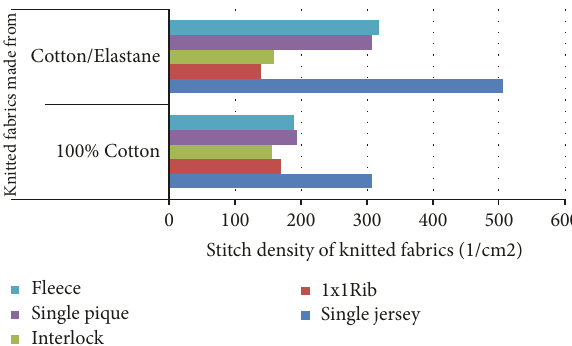
Figure 4: Stitch density of knitted fabrics made from 100% cotton and cotton/elastane yarns.